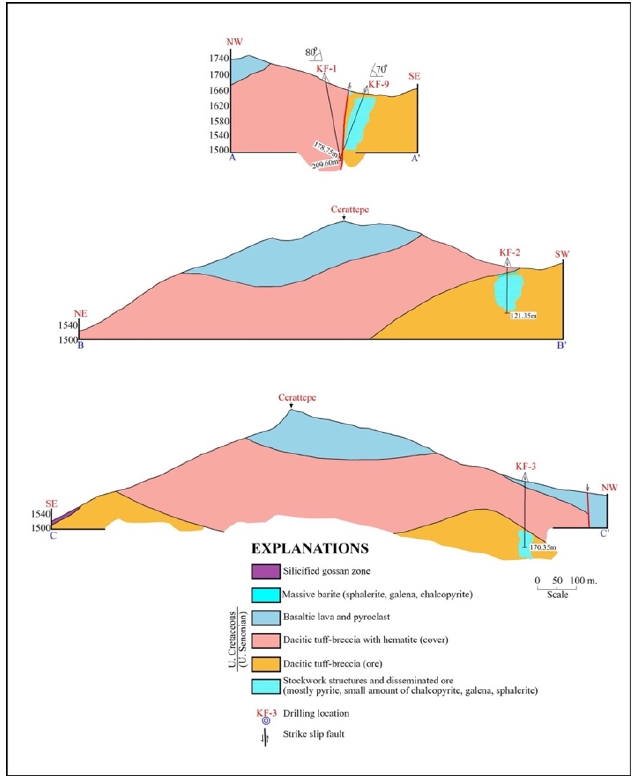
Figure 4. Cross-sections the Cerattepe-Artvin area, modified after [31].